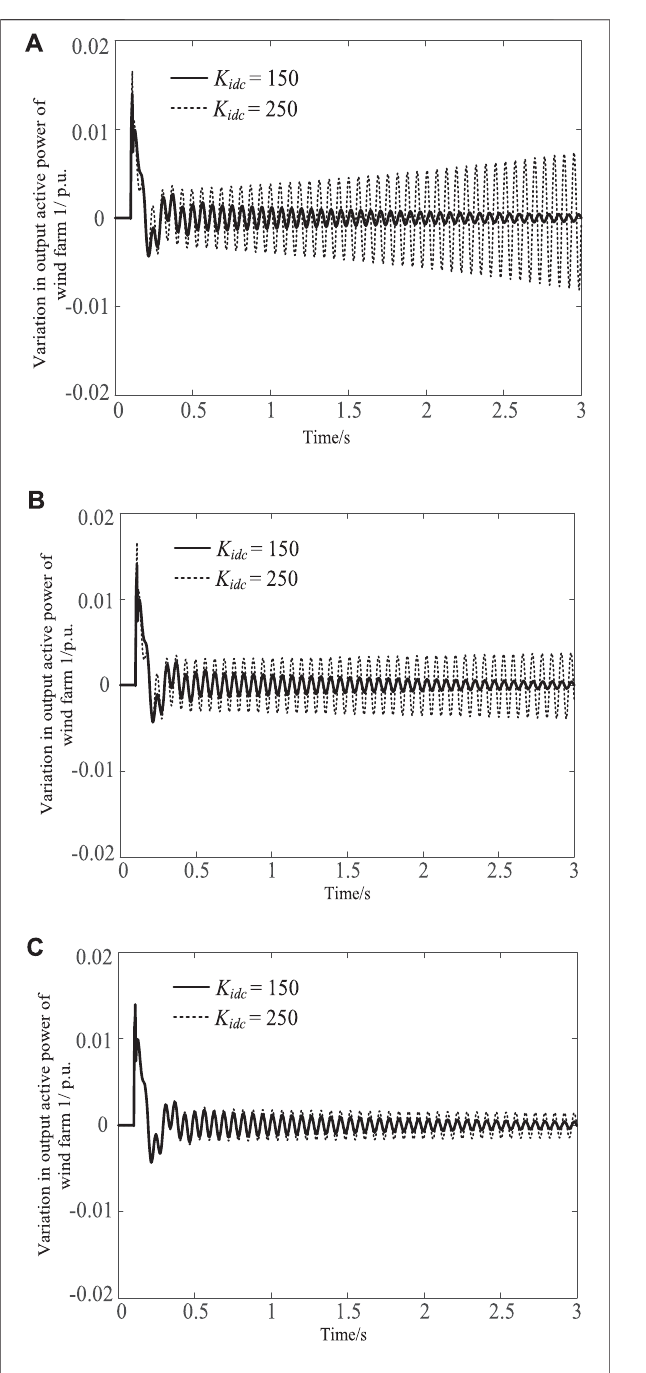
FIGURE 10 | Nonlinear simulation results: (A) X L (cid:1) 0.5, (B) X L (cid:1) 0.4, and (C) X L (cid:1) 0.3.